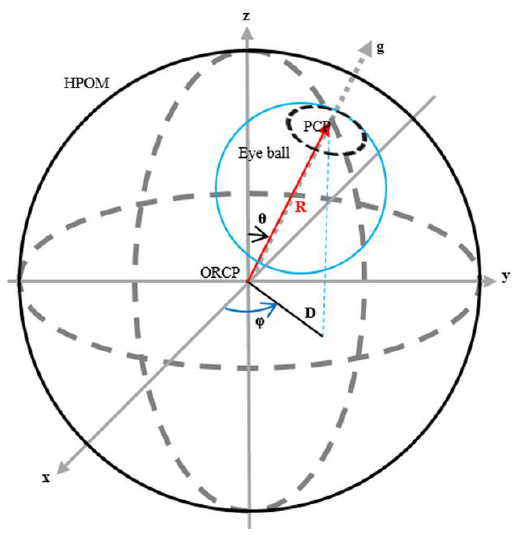
Figure 1. Relationships between PCP and ORCP in Spherical Coordinates.